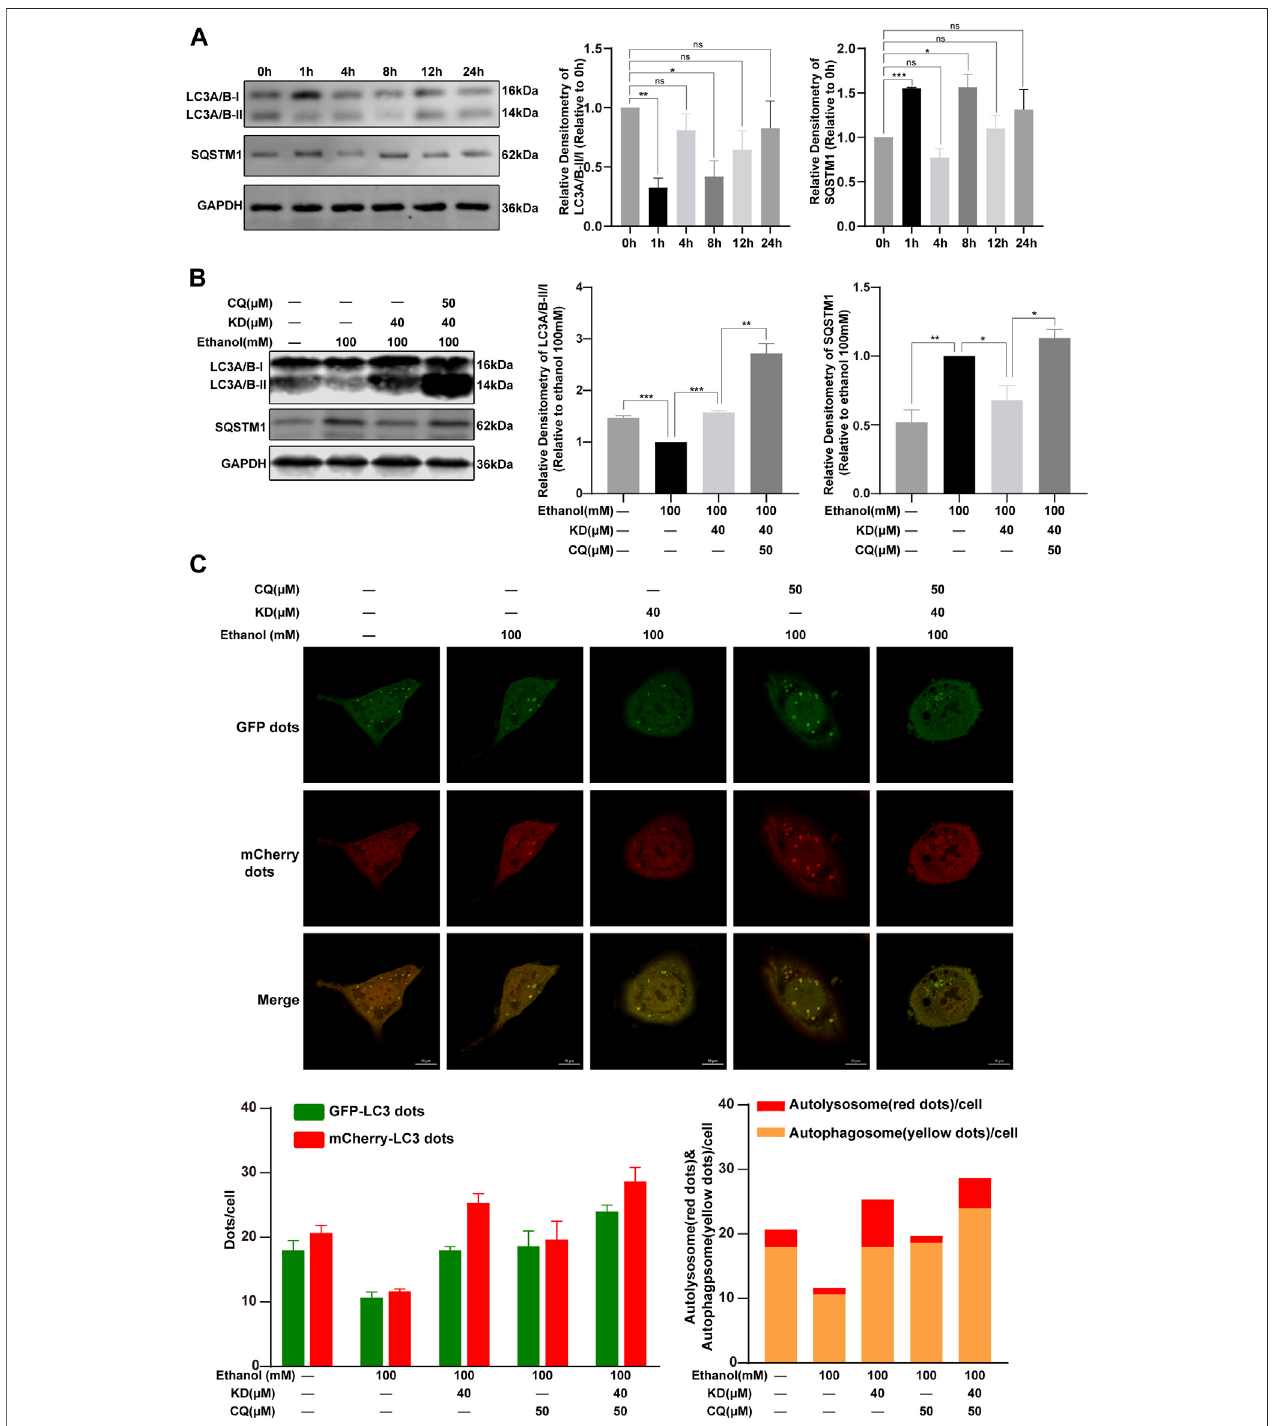
FIGURE 8 | KD restores ethanol-suppressed autophagic fl ux. (A) The effect of 100 mM ethanol for different time on autophagy. (B) KD affect the autophagy of ethanol in cells. (C) Confocal fl uorescence image and analysis of KD promoting the recovery of autophagic fl ux. Red puncta represent autolysosomes, yellow puncta (merged by red and green) represent autophagosomes. ( n (cid:1) 3). Data represent the mean ± SEM. GAPDH was used as a loading control. ns, not signi fi cant. * p < 0.05, ** p < 0.01, *** p < 0.001. Scale bar: 10 µm.